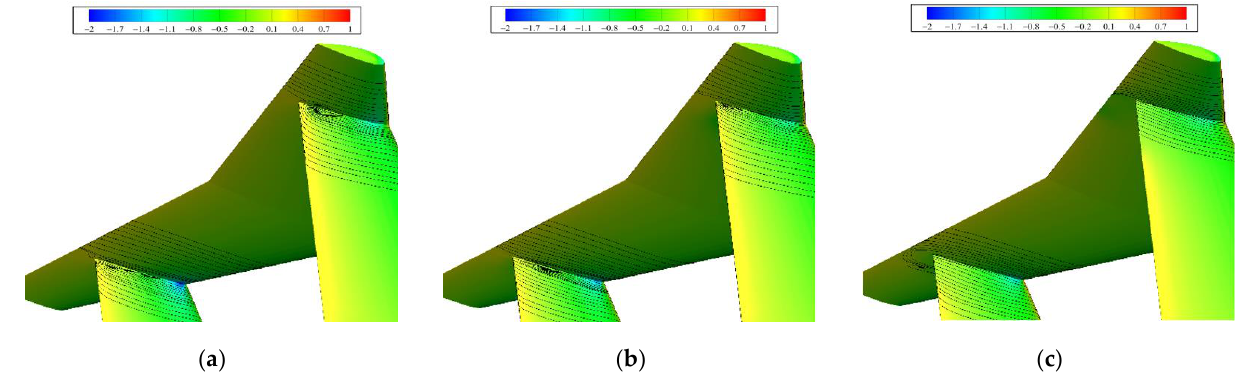
Figure 11. Streamlines and C p distribution on the pressure side of the vertical tail parts: β = ( a ) 0°, ( b ) 2°, and ( c ) 4°.